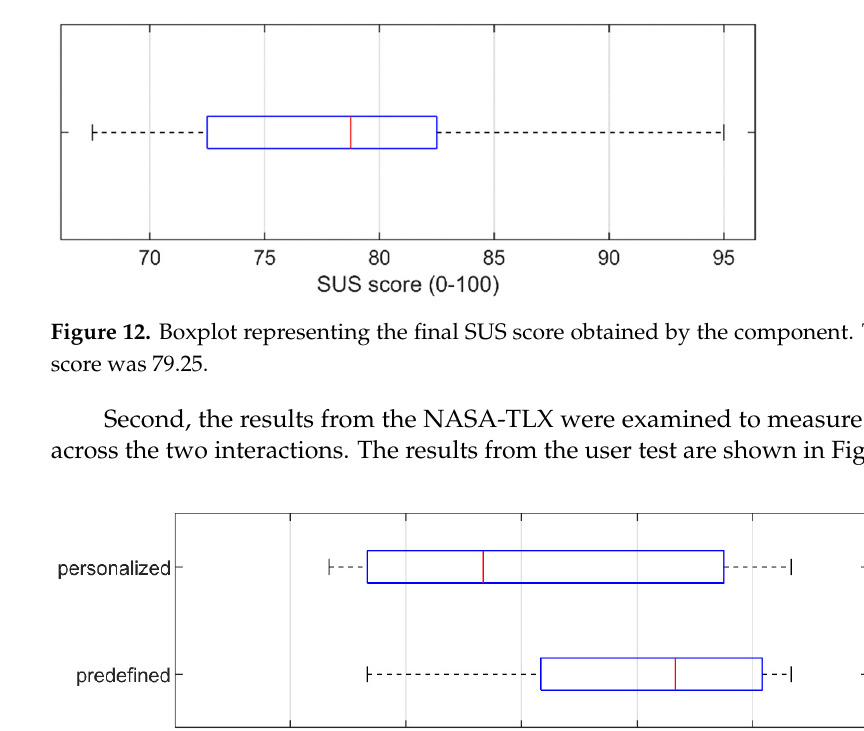
Figure 14. Boxplots representing the average score in the ( a ) mental and ( b ) physical workload. The personalized interaction displayed a statistically significant lower mental and physical workload when compared with the predefined gestures. Finally, in the last section, the users were asked if they liked being able to personalize the gestures and if they had to calibrate the glove. Nine out of the ten users preferred the interaction with the personalized gestures. Therefore, in gestural communication applica- tions, the personalization option of the gestures should be considered when creating such solutions. Second, out of the 10 users, none had to perform a re-calibration, thus suggest- ing that a well-calibrated glove can work universally with multiple users. However, the tasks in the use case did not have much object manipulation, and therefore the thresholds can be calibrated to be looser than the tasks including an object manipulation. Therefore,